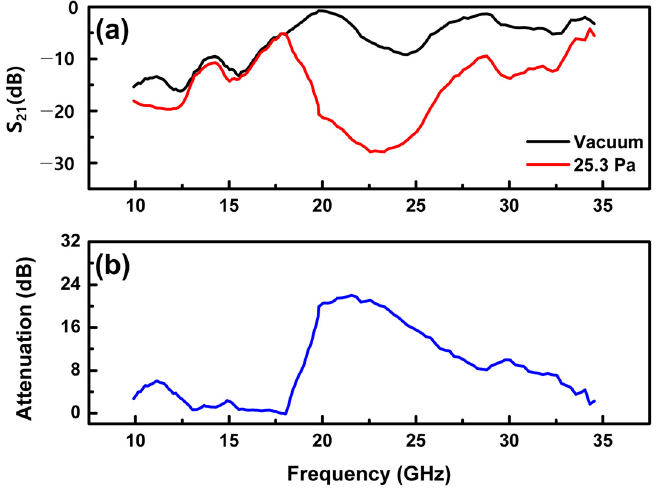
Figure 5. Interferometry experiment results according to frequency sweep; ( a ) S 21 measurement results ( b ) attenuation measurement results.